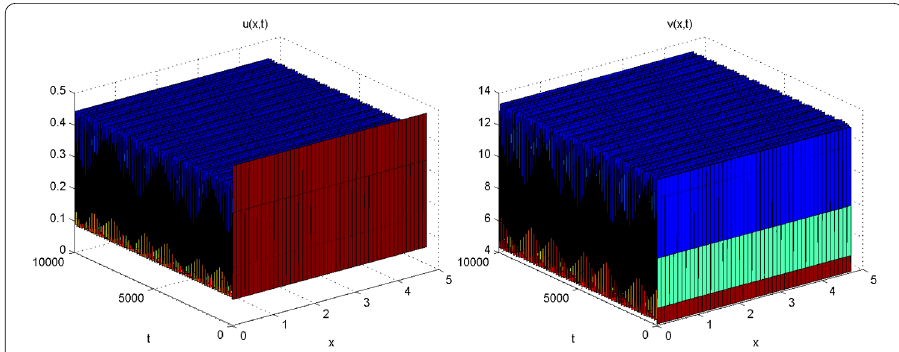
Figure 3 For system (4.1), s = 10 and the initial condition is (0.5,8.2). Left component: u ( x , t ) (Stable). Right component: v ( x , t ) (Stable).